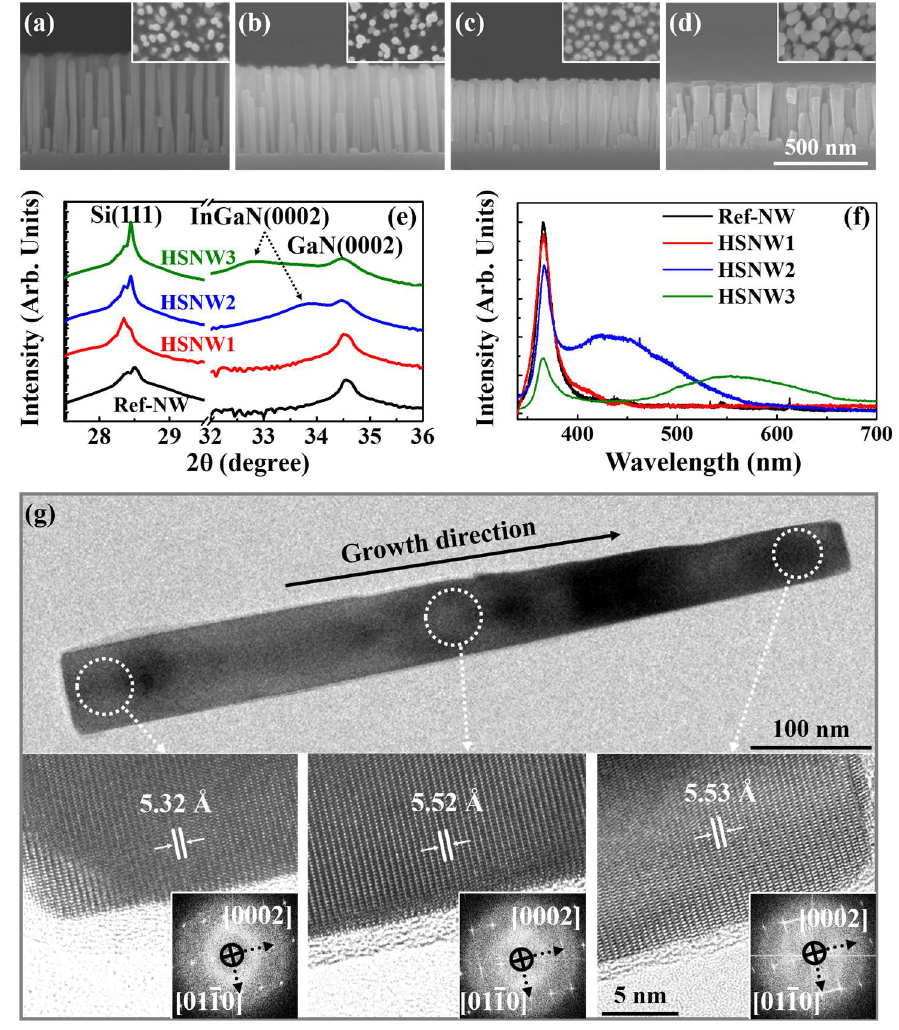
Figure 2. Cross-sectional FE-SEM images of the ( a ) Ref-NW, ( b ) HSNW1, ( c ) HSNW2, and ( d ) HSNW samples, where the insets are the plan-view images. ( e ) Normalized XRD rocking curves and ( f ) PL spectra of the Ref-NW, HSNW1, HSNW2, and HSNW3 samples. ( g ) Cs-TEM image ( top ), HR-TEM images ( bottom ), and the SAED patterns ( inset ) for the ( top ), ( middle ), and the ( bottom ) regions of the InGaN/GaN HSNW.